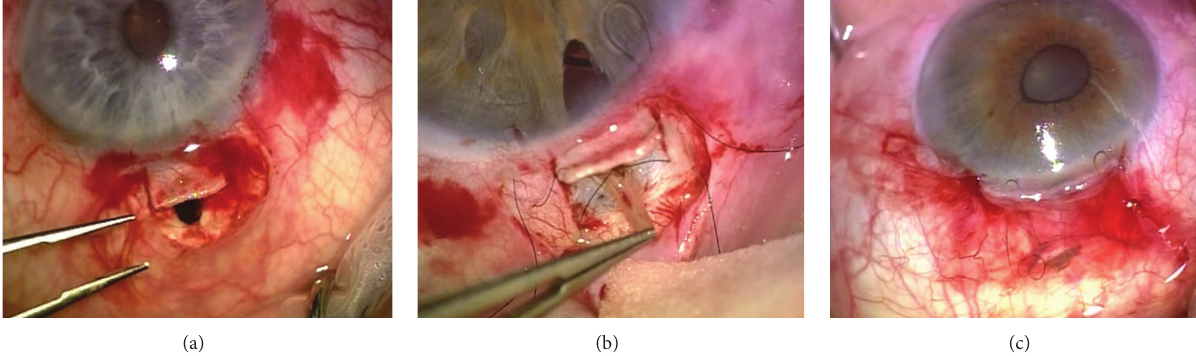
Figure 1: Surgical steps in different patients. (a) Iris flap extending beyond the scleral flap. (b) Iris grasped by forceps, pigment has already been removed. (c) Iris can be visible under the conjunctiva after closure.